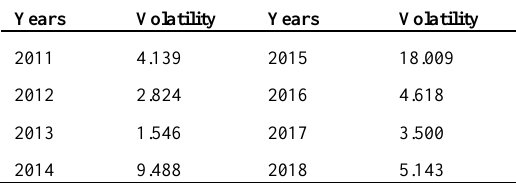
Table 8. Volatility by years